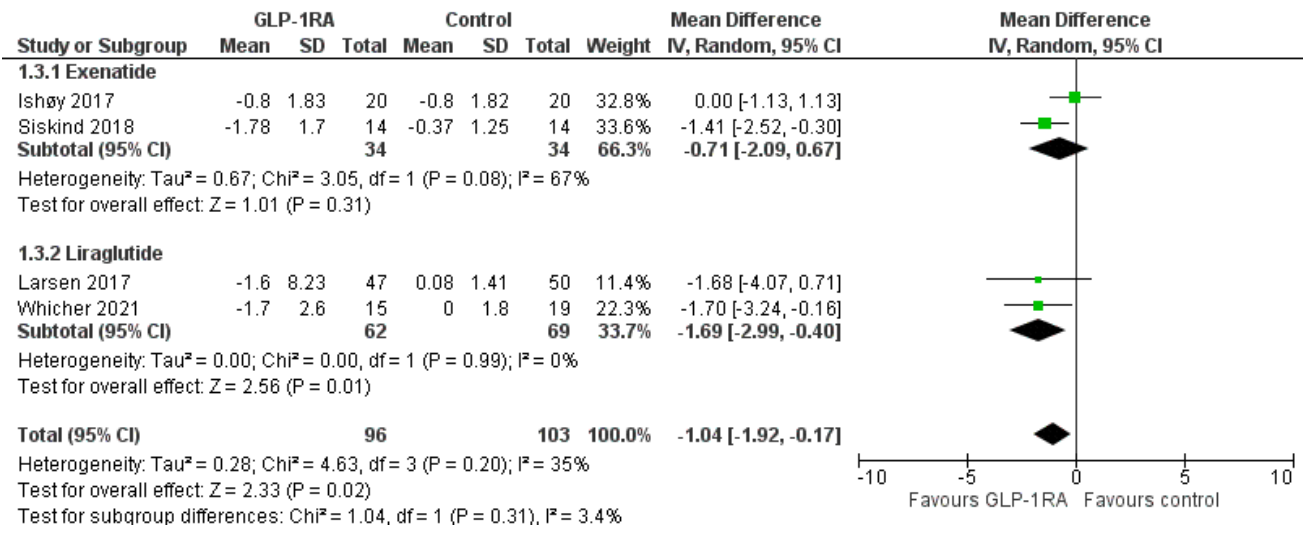
Figure 3. Effect of GLP-1RAs compared to controls on body mass index among individuals treated with antipsychotic drugs. The diamond represents the overall effect estimate of the meta-analysis. The findings of each study are plotted as one square.